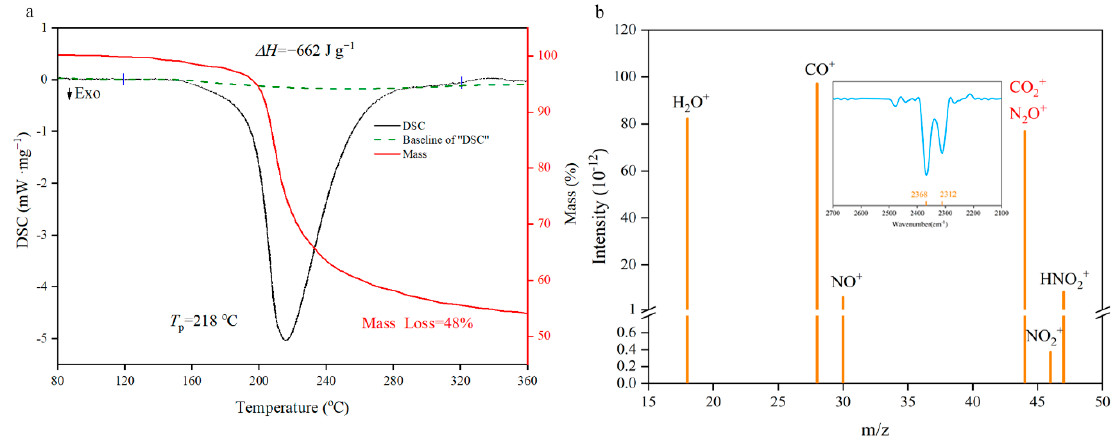
Figure 7. Differential scanning calorimetry (DSC)-thermogravimetry (TG)-mass spectrum (MS)-FTIR characterization diagrams. ( a ) The TG/DSC spectra of NGO; ( b ) the MS intensity spectra of gas fragments with m / z as 18(H 2 O + ), 28(CO + ), 30(NO + ), 44(N 2 O + or CO 2+ ), 46(NO 2+ ) and 47(HNO 2+ ). IR spectra in the range of characteristic wavelength shown on the top. Table 2. Thermal analysis